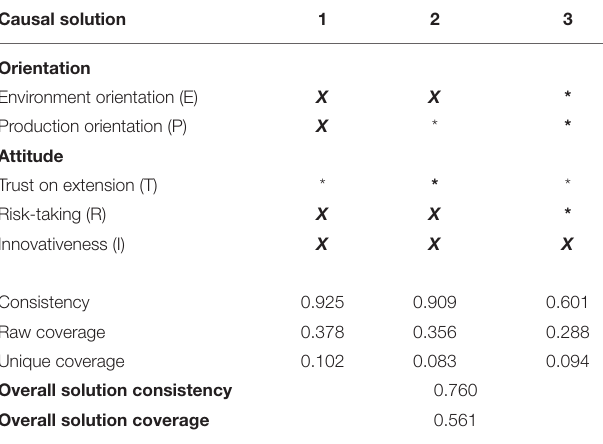
TABLE 6 | Configuration for study